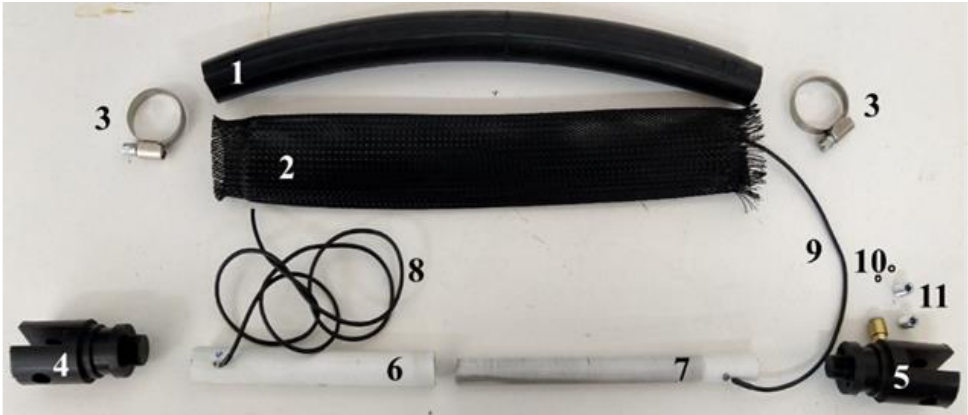
Figure 7. Components of the proposed MKM: (1) hyper-elastic tube; (2) braided gauze; (3) couple of metallic bands; (4) simple end; (5) complex end with the pneumatic fitting previously assembled; (6) outer and (7) inner tubes of the cylindrical capacitor CC2016; shielded cables previously assembled to the outer (8) and inner (9) tubes of the capacitor CC2016; (10) couple of O-Rings; (11) couple of internally drilled set screws.